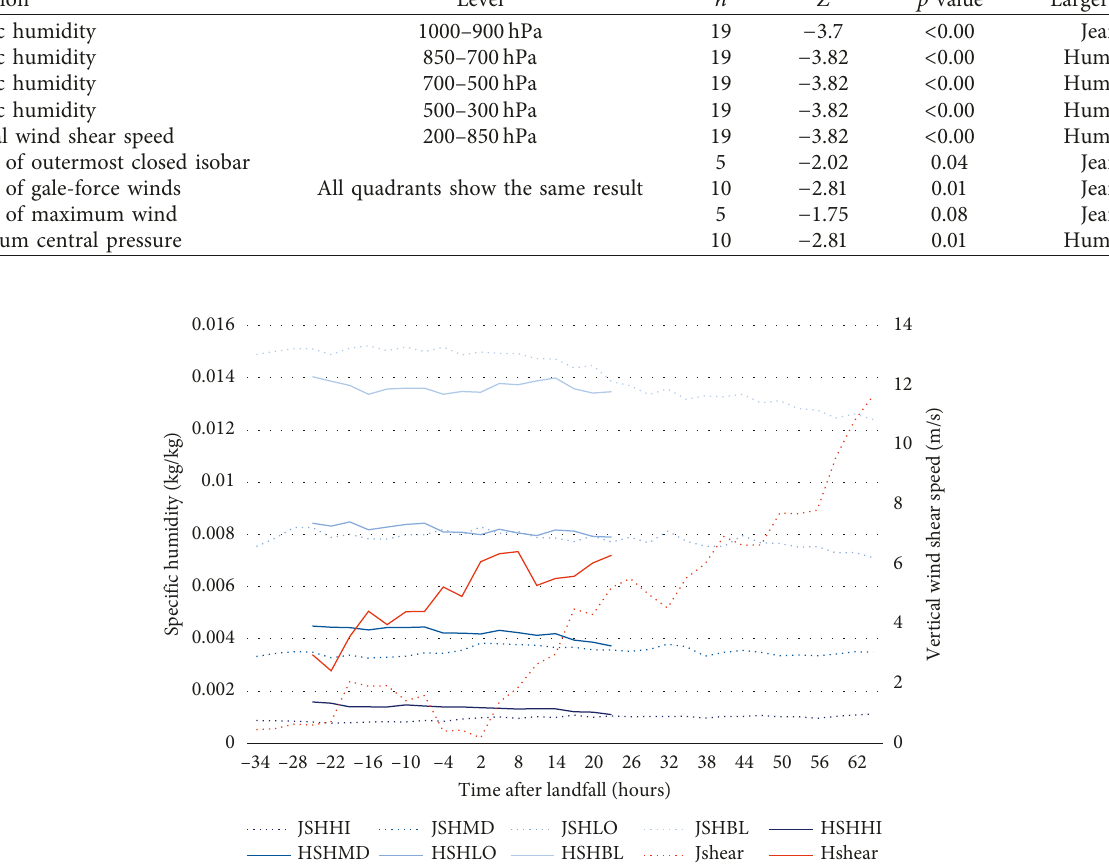
Figure 2: Comparison of specific humidity (SH) averaged across four ranges of altitude (boundary layer (BL), 850–700hPa (LO), 750–500hPa (MD), and 500–300hPa (HI)) and deep-layer vertical wind shear for Jeanne (J) and Humberto (H).